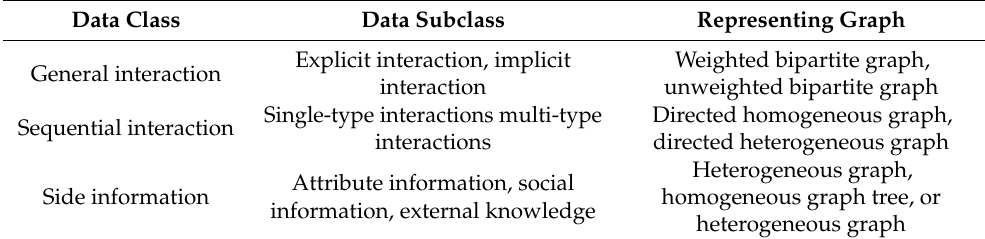
Table 3. A summary of data representation in RSs and representing graphs [72]. Data Class Data Subclass Representing Graph Explicit interaction, implicit Weighted bipartite General interaction interaction